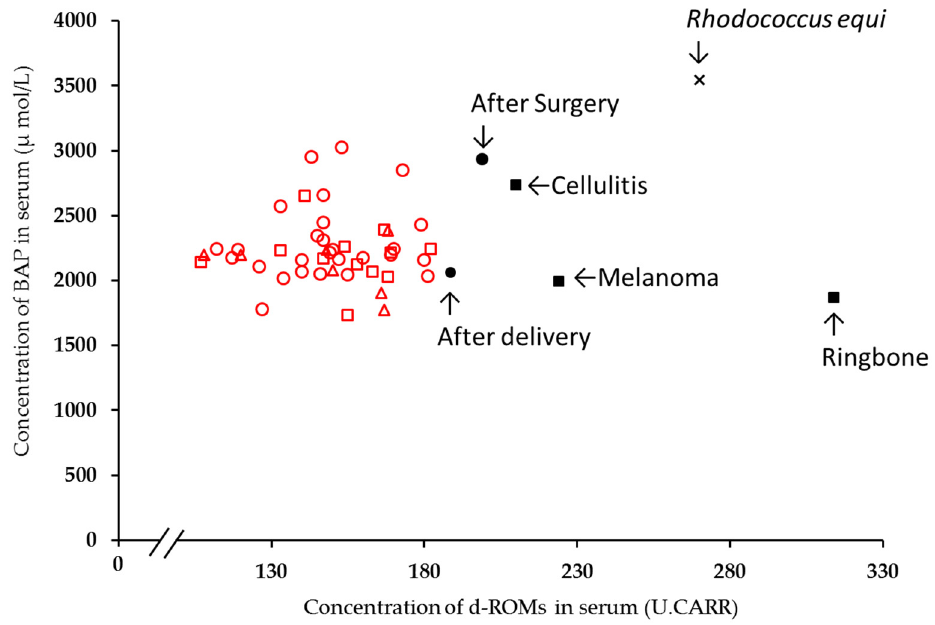
Figure 3. Comparison between d-ROM and BAP concentrations in serum of horses in an equestrian club in Shizuoka Prefecture and that of horses suffering disease or other stress. Red symbols: horses in an equestrian club in Shizuoka Prefecture in our study (circle: thoroughbreds; square: ponies; triangle: full-sized horses other than thoroughbreds). Black symbols: horses suffering disease or other stress (square: horses in our study; other symbols: data from previous reports [21–23]).